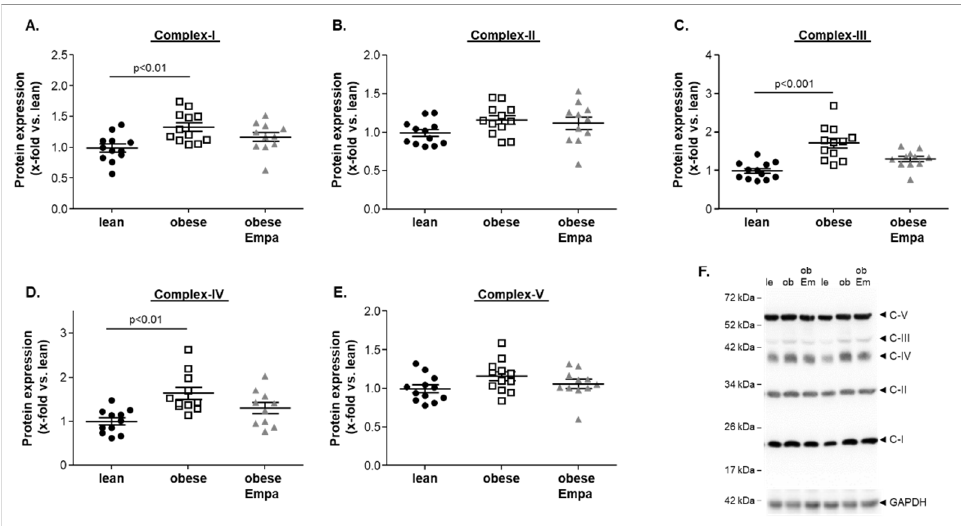
Figure 5. Protein expression of mitochondrial respiratory complex I–V ( A – E ) was quantified by western blot analysis in soleus muscle homogenates obtained from ZSF1-lean (lean, black circles), ZSF1-obese (obese, open squares) and ZSF1-obese rats treated with Empagliflozin (obese + Empa). A representative western blot is shown ( F ). Results are expressed as mean ± SEM ( n = 11–12 per group).